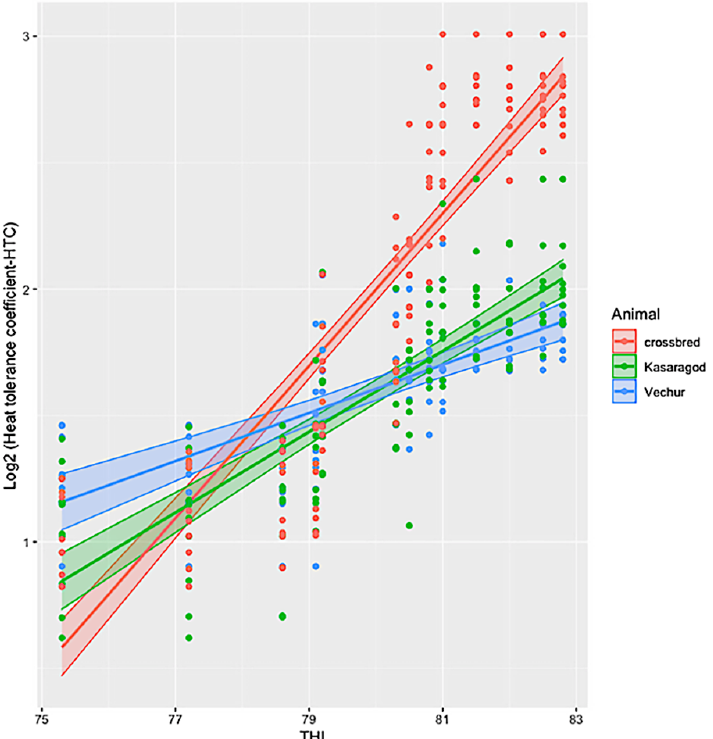
Figure 2. Estimated marginal means of heat tolerance coefficient (HTC) in crossbred, Kasaragod, and Vechur cattle at different THI levels.